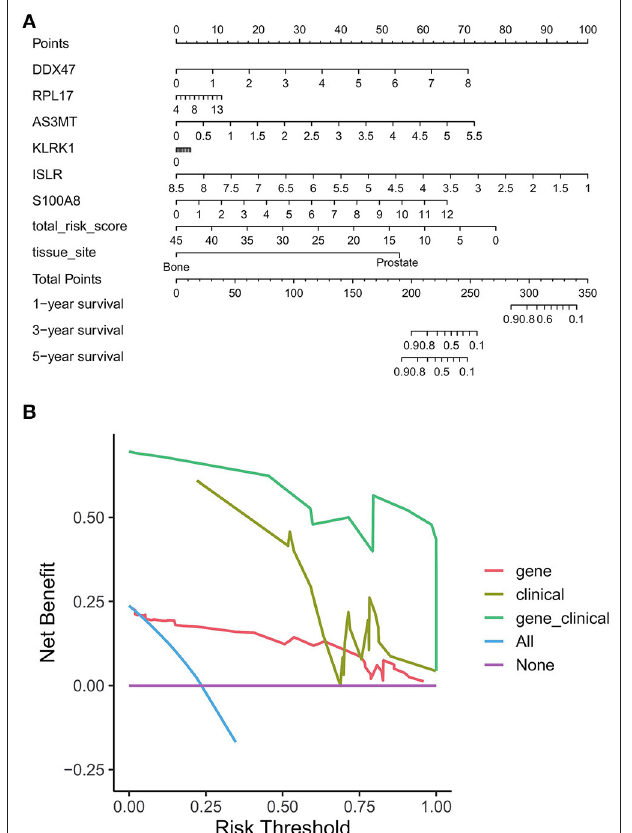
FIGURE 12 | Benefit assessment of bone metastasis-related prognostic models applied to the clinical setting. (A) Nomogram with bone metastasis prognostic genes and clinical factors for predicting OS in PRAD. (B) DCA of benefit rates for models of bone metastasis prognostic genes and clinical factors vs. clinical factor models, and bone metastasis prognostic genes.